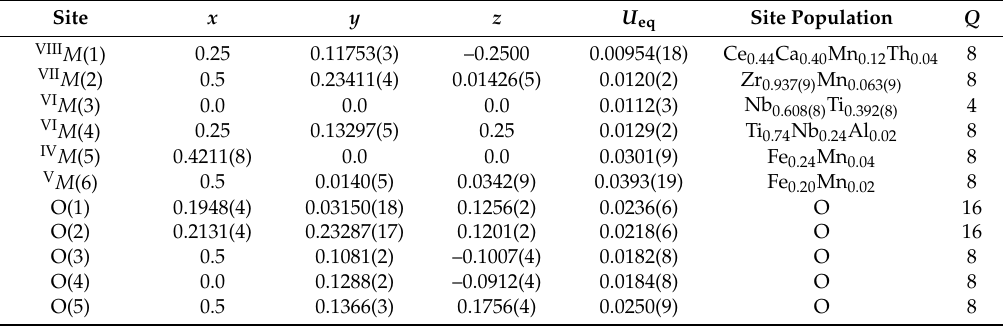
Table 5. Atom coordinates, equivalent thermal displacement parameters ( U eq , Å 2 ), site populations and site multiplicities ( Q ) in the structure of nöggerathite-(Ce).